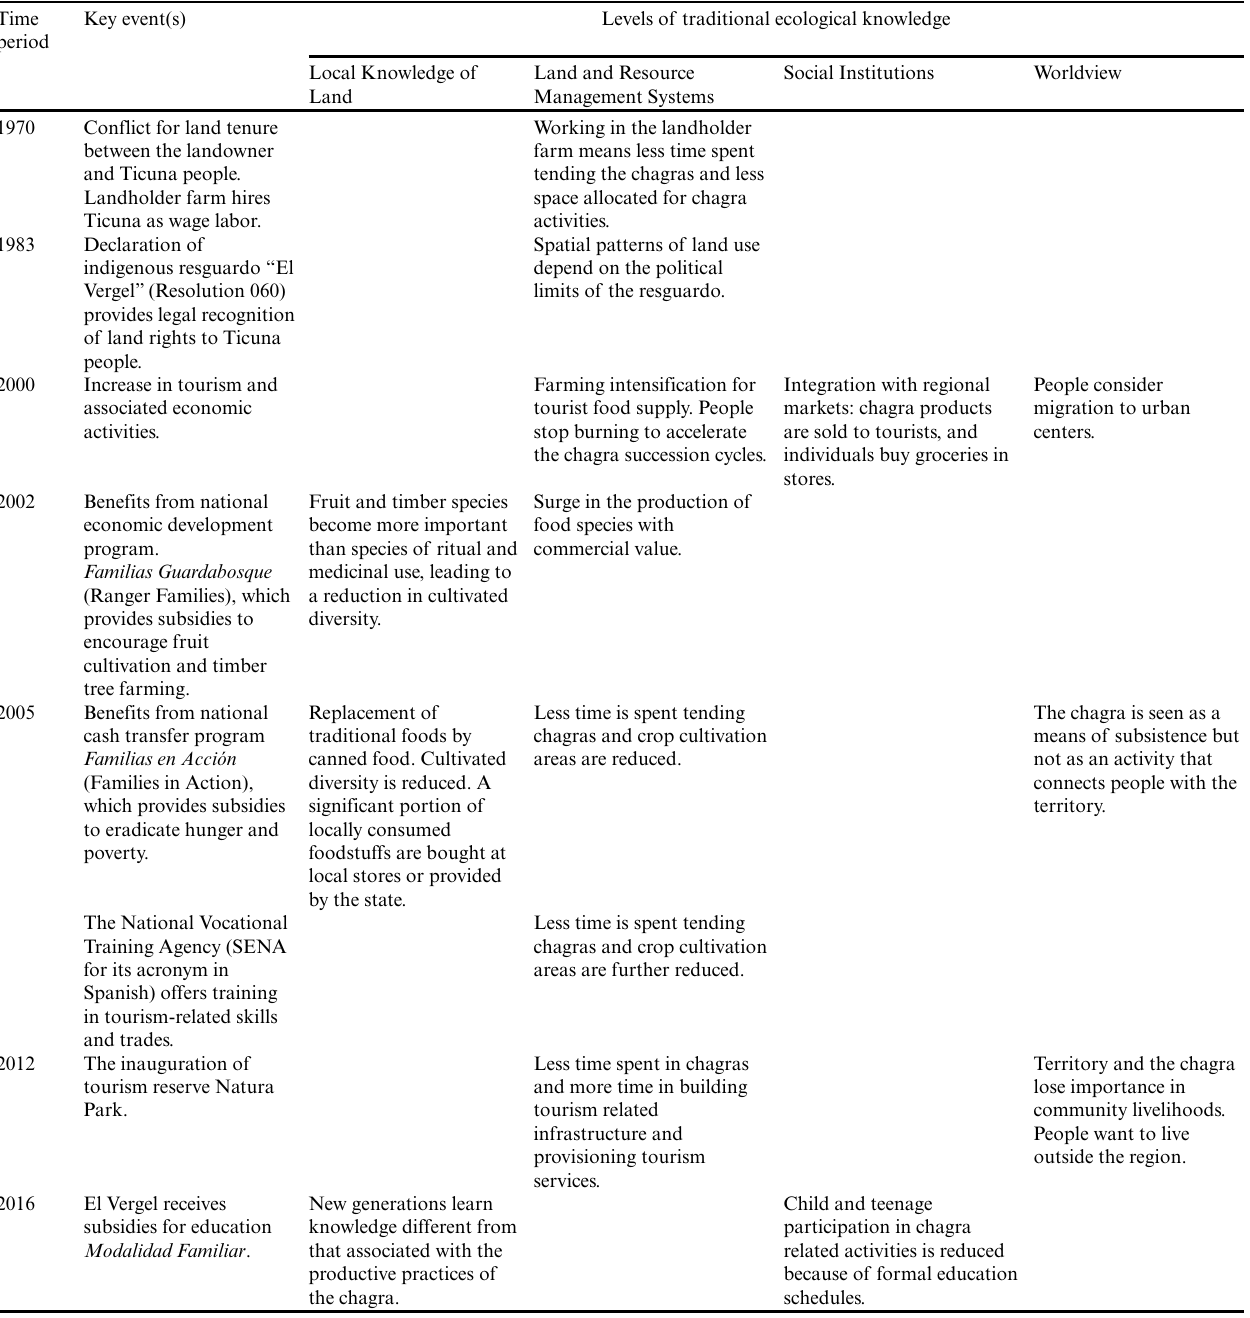
Table 2 . Socioeconomic (SE) drivers of change and traditional ecological knowledge (TEK) transformations in El Vergel Resguardo. Time